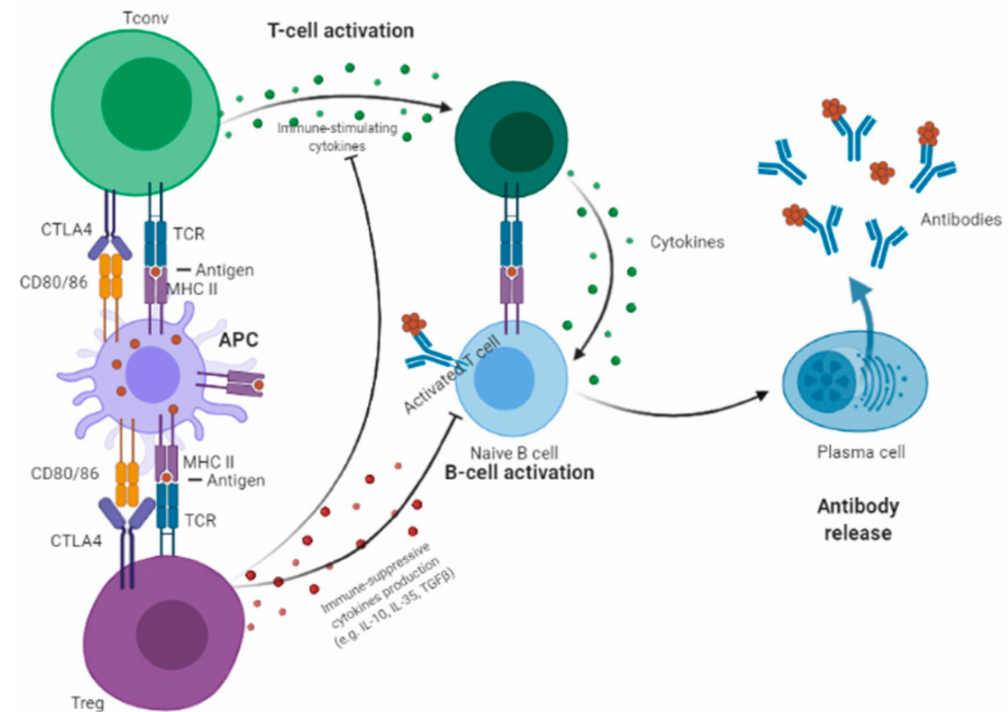
Figure 1. Regulatory T (T reg ) cells inhibit antigen-presenting cells (APC) by three main mechanisms: (1) Depleting immune- stimulating cytokines; (2) producing immunosuppressive cytokines (e.g., TGF- β , IL-10, and IL-35); and (3) constitutively expressing CTLA-4, which blocks the priming and activation of naïve CD4+ T (T conv ) cells to